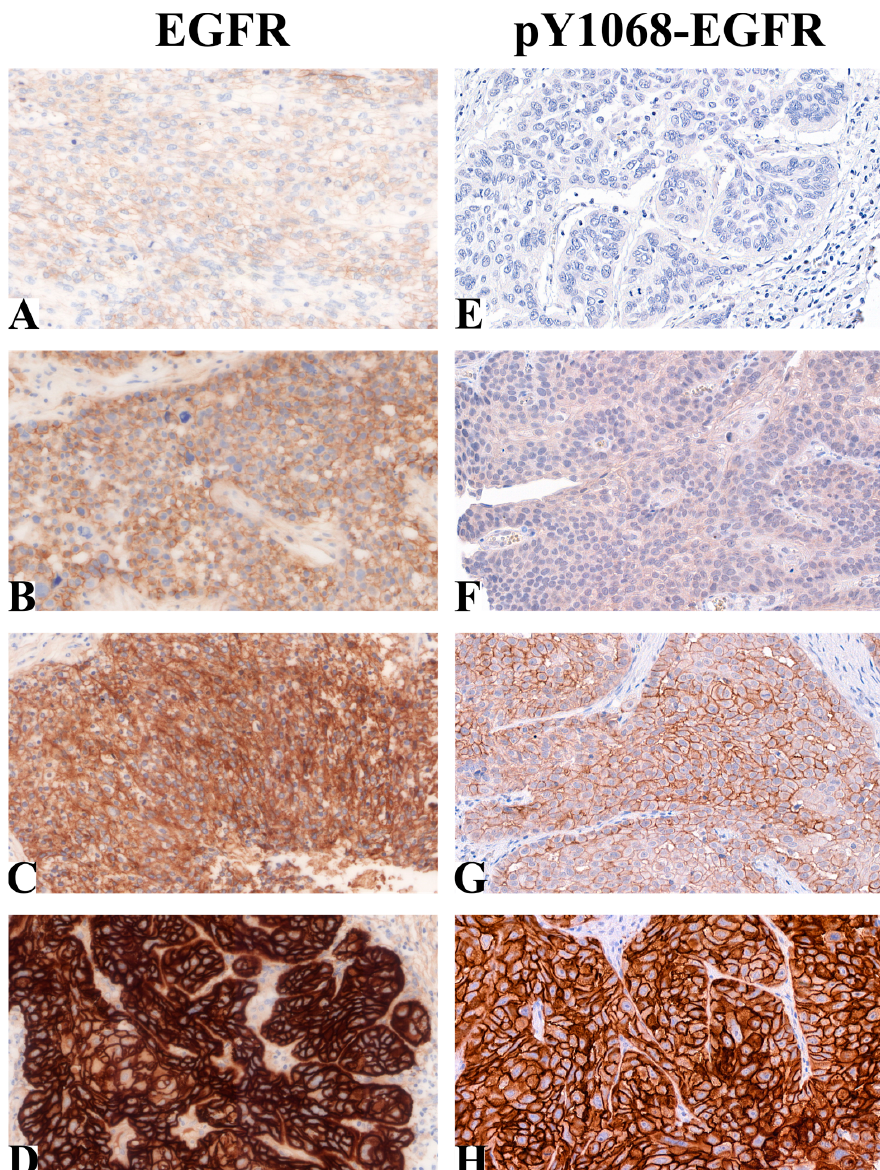
Figure 1. Immunohistochemical analysis of EGFR and pY1068-EGFR levels. ( A ) Negative, ( B ) low, ( C ) intermediate and ( D ) high EGFR levels in HNSCC tissue samples. ( E ) Negative, ( F ) low, ( G ) intermediate and ( H ) high pY1068-EGFR levels in HNSCC tissue samples (magnification: 40×). A high EGFR expression (EGFR H ) was found in 78/84 (92.3%) of the HNSCC samples. The EGFR status did not correlate with disease-specific survival (DSS, p = 0.551), tumor localization ( p = 0.369), tumor size ( p = 0.690), lymph-node metastasis ( p = 0.525), distant metastasis ( p = 0.522), stage ( p = 0.182), smoking ( p = 0.866) or alcohol consumption ( p = 0.707). However, we found a significant association with tumor grade ( p = 0.031); in other words, high EGFR expression was associated with higher grade. Of the sixty-three tumor samples, six (9.5%) showed high pY1068-EGFR levels (pY1068-EGFR H ). Furthermore, the pY1068-EGFR status was correlated with the DSS ( p = 0.036); that is, increases in pY1068-EGFR-expression levels were associated with poorer prognoses (Figure 2). However, the pY1068-EGFR status did not correlate with tumor lo- calization ( p = 0.748), tumor size ( p = 0.303), distant metastasis ( p = 0.406), stage ( p = 0.273),